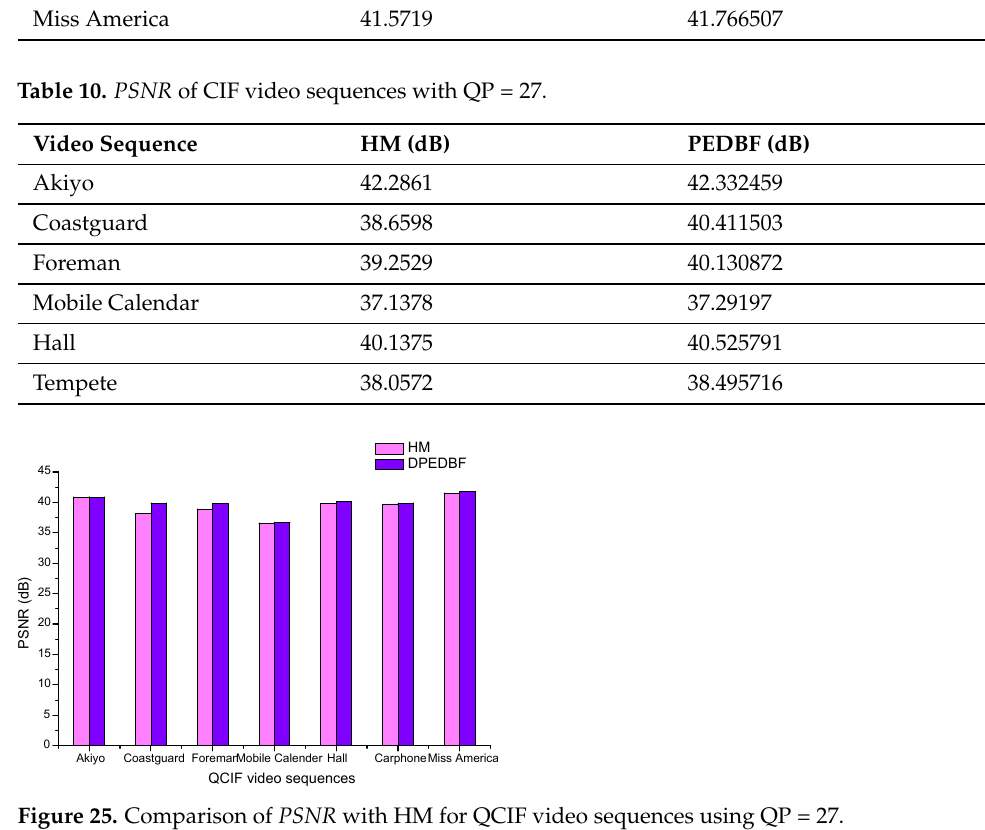
Figure 25. Comparison of PSNR with HM for QCIF video sequences using QP = 27.